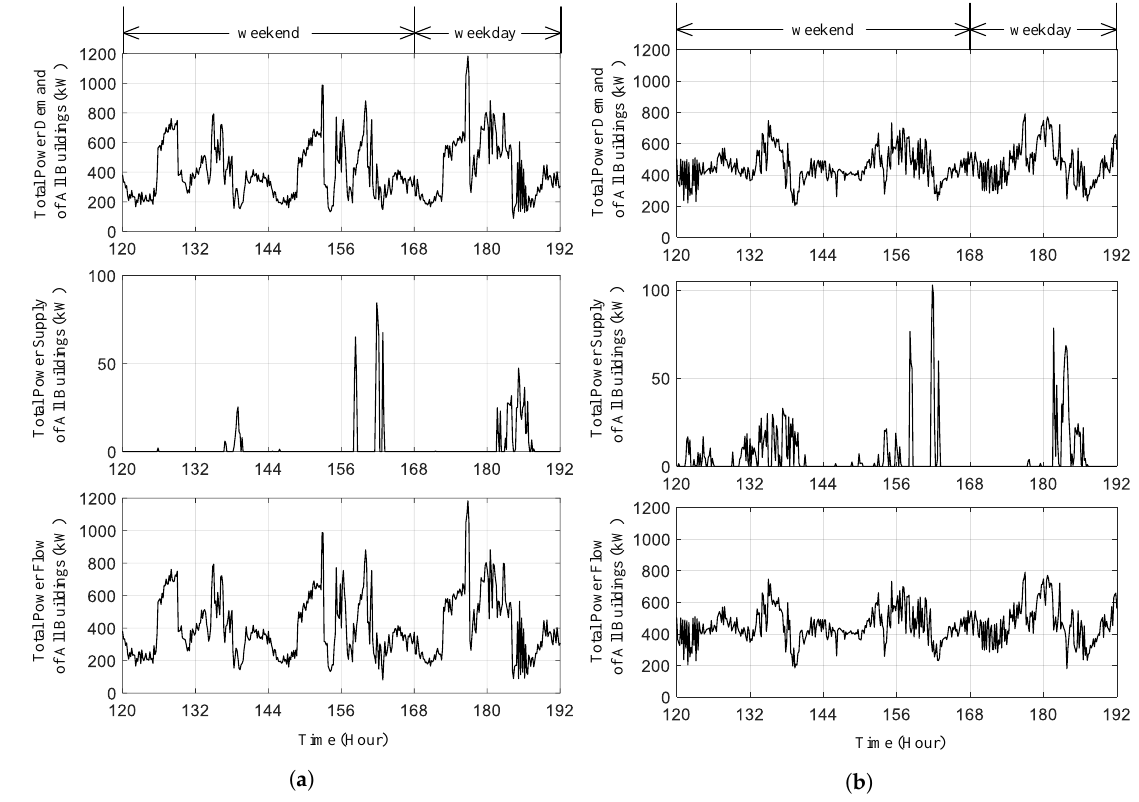
Figure 9. Weekend overall power flow profiles of microgrid: ( a ) without dissipativity based coordination; ( b ) with dissipativity based